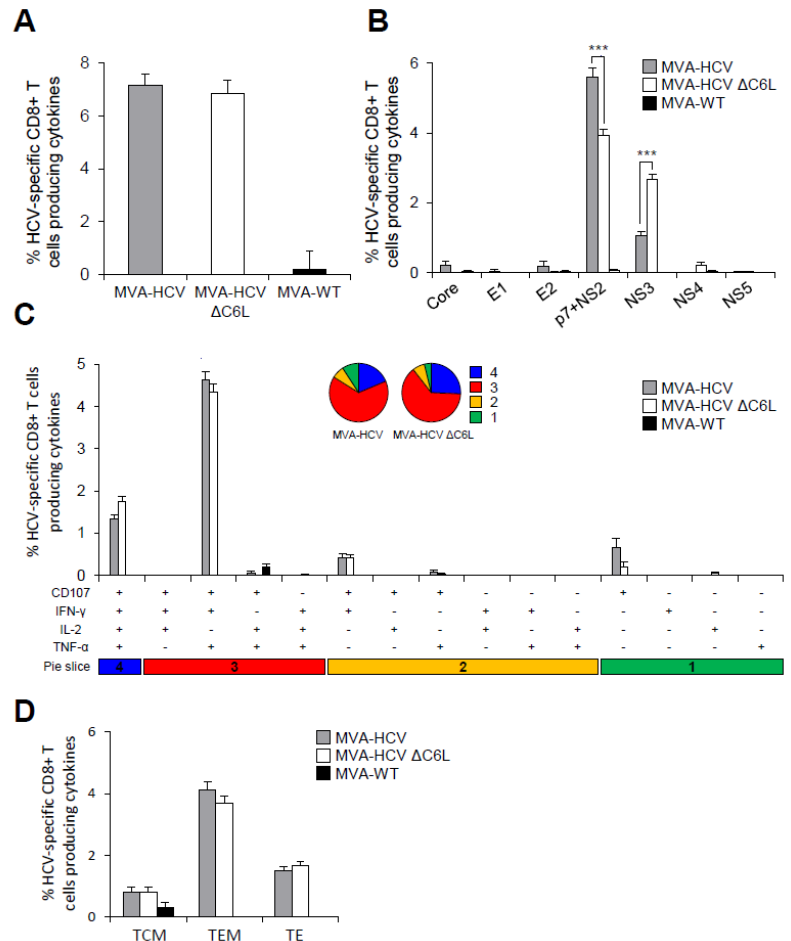
Figure 6. Magnitude, breath, polyfunctionality, and phenotype of HCV-specific CD8 + T cell memory immune responses. Splenocytes were obtained from mice ( n = 4 per group) immunized with two doses of MVA-WT, MVA-HCV, or MVA-HCV ∆ C6L 53 days after the last immunization. Then, HCV-specific CD8 + T cell memory immune responses elicited were measured by ICS after stimulation of splenocytes with different HCV peptide pools. Values from unstimulated controls were subtracted in all cases. p values indicate significantly response differences when comparing MVA-HCV with MVA-HCV ∆ C6L (*** = p ≤ 0.001). Data is from one experiment representative of four independent experiments. ( A ) Percentage of total HCV-specific CD8 + T cell memory immune responses directed against HCV antigens. The values represent the sum of the percentages of CD8 + T cells producing CD107a and/or IFN- γ and/or TNF- α and/or IL-2 against Core, E1, E2, p7 + NS2, NS3, NS4, and NS5 peptide pools. ( B ) Percentages of Core, E1, E2, p7 + NS2, NS3, NS4, or NS5 HCV-specific CD8 + T cells. Frequencies represent the sum of the percentages of CD8 + T cells producing CD107a and/or IFN- γ and/or TNF- α and/or IL-2 against each HCV peptide pool. ( C ) Polyfunctionality profile of total HCV-specific CD8 + T cell memory immune responses directed against HCV antigens and producing CD107a and/or IFN- γ and/or TNF- α and/or IL-2. Responses are grouped and color coded, taking into consideration the number of functions (one, two, three, or four). Each slice in the pie charts corresponds to the proportion of the total HCV-specific CD8 + T cells exhibiting one, two, three, or four functions (CD107a and/or IFN- γ and/or TNF- α and/or IL-2) within the total HCV-specific CD8 + T cells. ( D ) Phenotypic profile of total HCV-specific CD8 + T cell memory immune responses directed against HCV antigens. Frequencies represent percentages of T central memory (TCM), T effector memory (TEM), and T effector (TE) HCV-specific CD8 + T cells producing CD107a and/or IFN- γ and/or TNF- α and/or IL-2 against HCV peptide pools. TCM, TEM, and TE phenotypes are determined on the basis of CD127 and CD62L expression: TCM (CD127 + , CD62L + ), TEM (CD127 + , CD62L − ), and TE (CD127 − , CD62L −